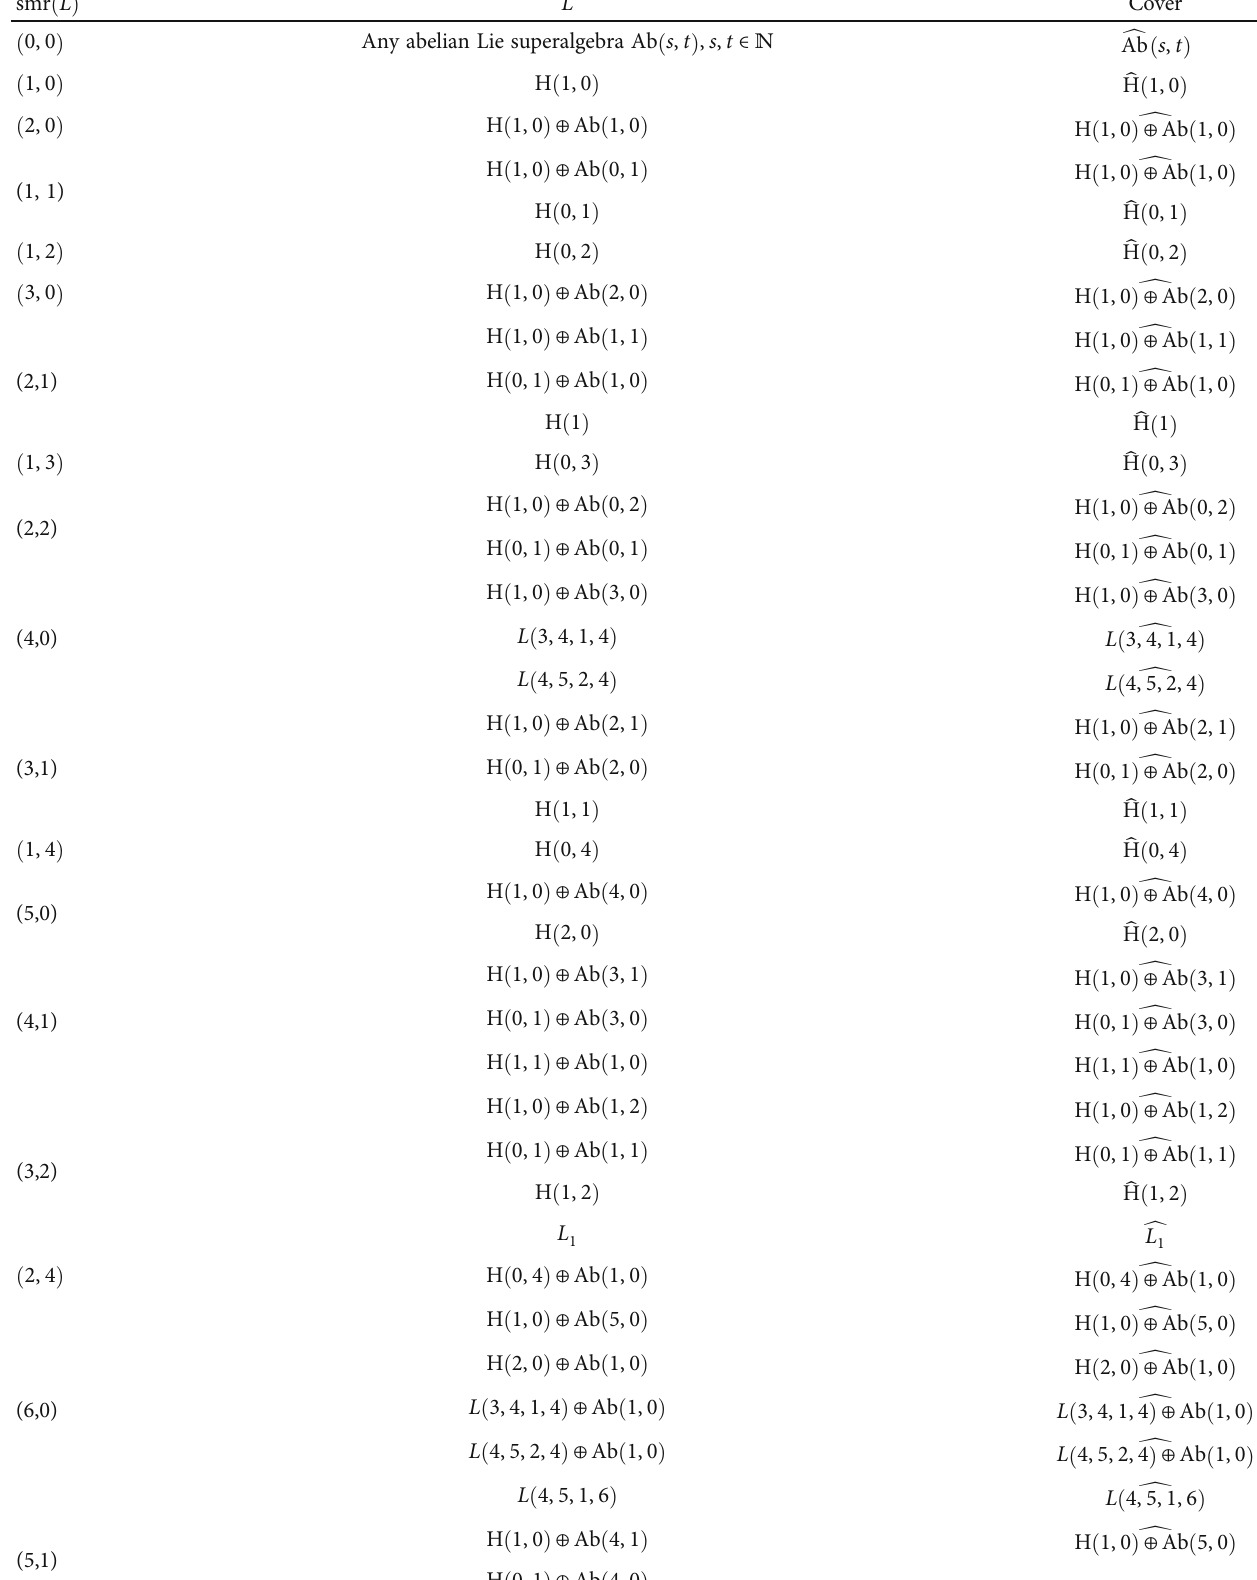
Table 1: The classi fi cation and